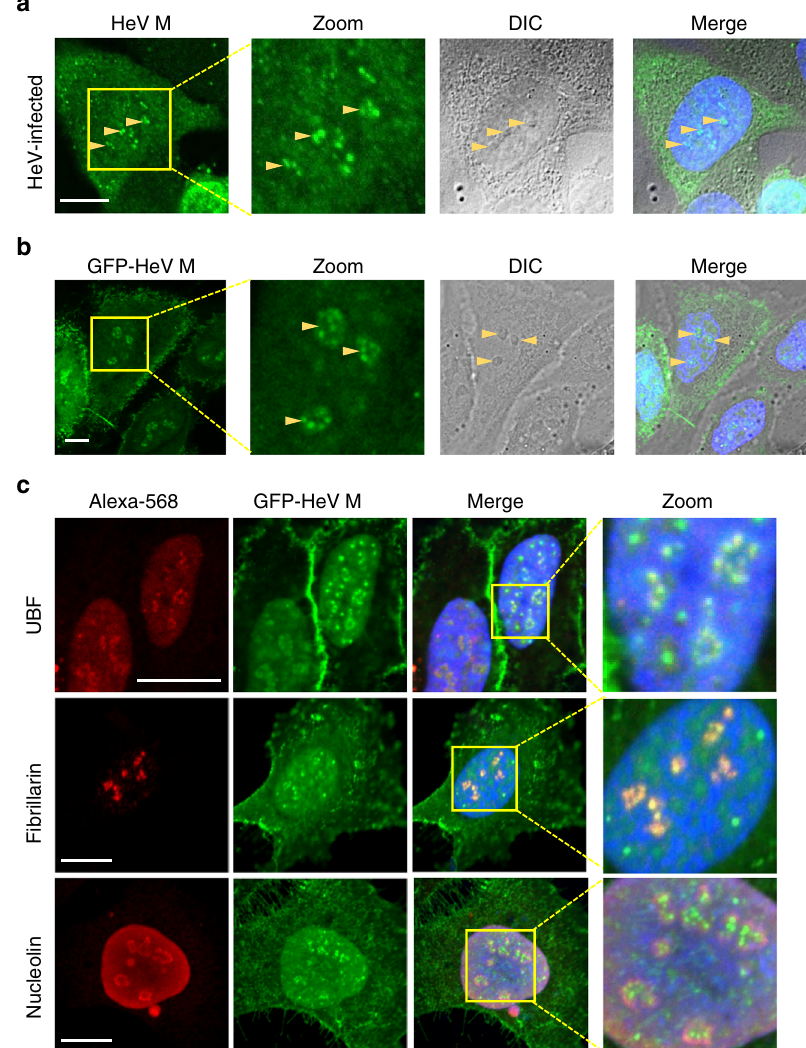
Fig. 1 HeV M protein localizes to discrete subnucleolar compartments in HeV-infected cells and cells transfected to express HeV M protein. a HeLa cells infected with HeV (multiplicity of infection (MOI) of 5) were fi xed 24 h post-infection (p.i.) and immunostained for HeV M protein before imaging by CLSM. b HeLa cells transfected to express GFP-HeV M protein were imaged live 16 h post-transfection (p.t.) by CLSM. Images are representative of ≥ 5 independent experiments, in each of which ≥ 10 fi elds of view were captured. c HeLa cells transfected to express GFP-HeV M protein were fi xed 16 h p.t. and immunolabeled for the indicated nucleolar proteins, using AlexaFluor-568-conjugated secondary antibodies. Images are representative of cells in ≥ 20 fi elds of view. Arrowheads indicate nucleoli. Nuclei (DNA) were labeled using Hoechst 33342 (blue in merged images). Yellow boxes highlight regions of images magni fi ed in the Zoom panel. Scale bars correspond to 15 μ